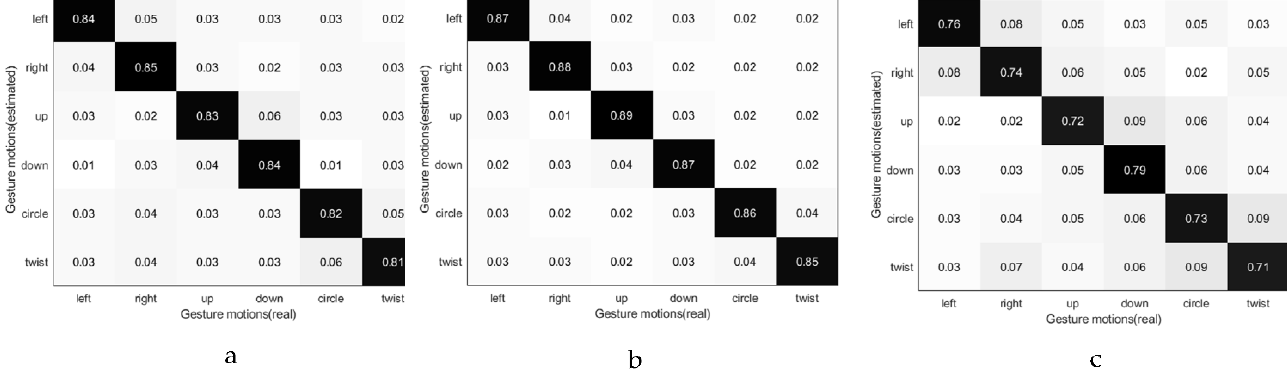
Figure 22. Confusion matrix. ( a ) The confusion matrix of the recognition results of the known scene domain, ( b ) The confusion matrix of unknown scene domain identification results, ( c ) The confusion matrix of the experimental location scene domain, ( d ) The confusion matrix of the experimental direction scene domain, ( e ) The confusion matrix of any scene domain in the experiment. 5. Conclusions This paper uses the three-dimensional CNN for cross-scene recognition of gestures collected by millimeter-wave radar. The experiment is to train and verify the gesture data collected in one experimental scene in another practical set. It shows that gesture recogni- tion by millimeter-wave radar has nothing to do with the scene domain. To verify that, millimeter-wave radar recognizes gestures independent of the scene domain. The experi- ments are designed with four scene domains (environment, location, orientation, and per- son). Motions are first collected from the scene domain. Then, the gesture data is pro- cessed—extraction to distance-time features, distance-doppler features, and distance-an- gle features. Using three gesture feature sets to describe gestures can solve the problem that gesture features in different scenes are difficult to adapt to other positions and gesture descriptions are incomplete. Then, these three feature sets are trained in the three-dimen- sional CNN. At the same time, the time dimension is introduced into the training of ges- ture features. Finally, gestures are recognized in different scene domains, illustrating that millimeter-wave radar recognizes gestures regardless of scene domain. Experiments show that motions in the scene domain (environment, location, orientation, and person) can be identified by other gestures in the scene domain. The experimental results show that the average recognition accuracy in the known scene domain is 87% and the average recogni- tion accuracy in the unknown scene is 83.1%. At the same time, the structure of the neural network is also an external factor that affects the experiment. It is analyzed to enhance the recognition system’s robustness and to verify its overall recognition effect. Author Contributions: Conceptualization, X.D., K.W. and Z.H.; methodology, X.D. and K.W.; soft- ware, K.W. and Z.M.; validation, X.D., K.W. and Z.H.; formal analysis, X.D., K.W. and Z.M.; inves- tigation, Z.H.; resources, X.D. and Z.H.; data curation, X.D., K.W. and Z.M.; writing—original draft preparation, K.W.; writing—review and editing, X.D., Z.H. and Z.M.; visualization, X.D. and Z.H.;